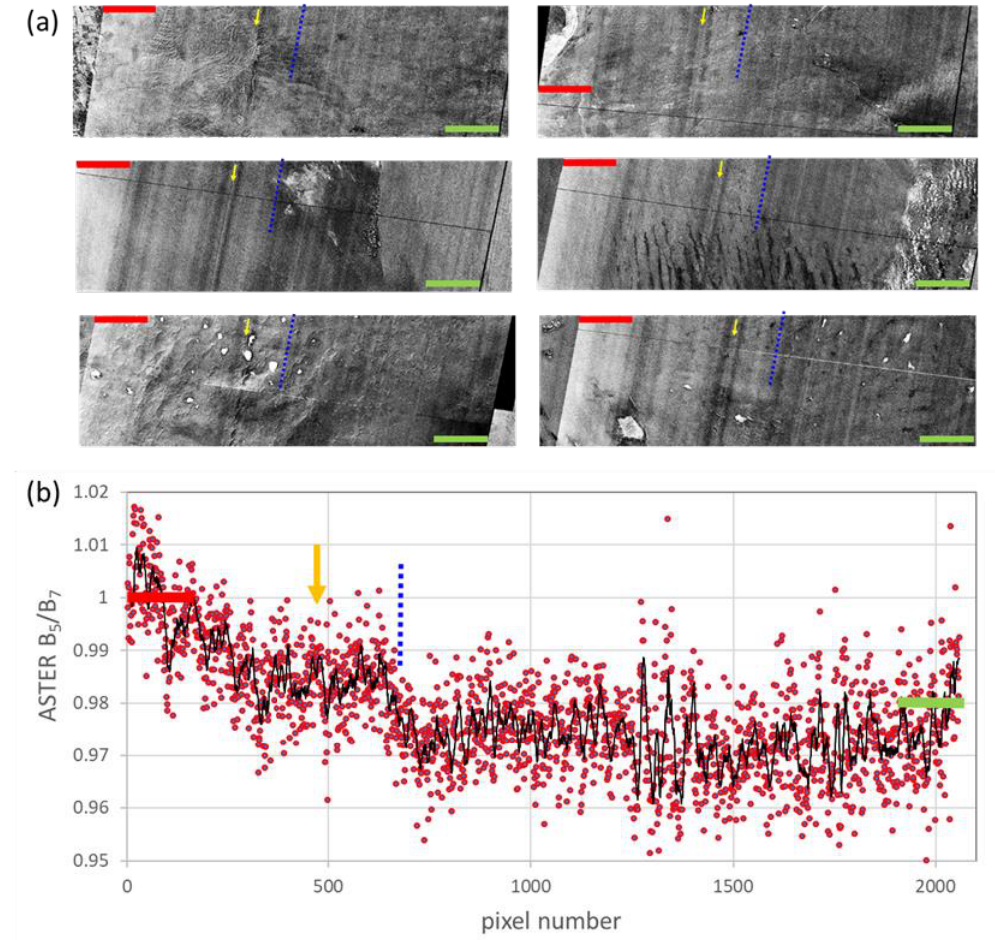
Figure A3. ( a ) A selection of six full-image-width segments from across the non-cross-calibrated ASTER B 5 / B 7 mosaic with each showing the similar systematic column noise, including: a broad ( < 200 pixels wide) bright band on the left side of each image (red line); a pair of narrow (~20 pixels) dark bands (yellow arrow); and a broad shoulder (blue dotted lines). ( b ) Scattergram of the ASTER scene pixel number versus the mean B 5 / B 7 values for six transects taken from ( a ). The 10-point moving average is shown as a black line.